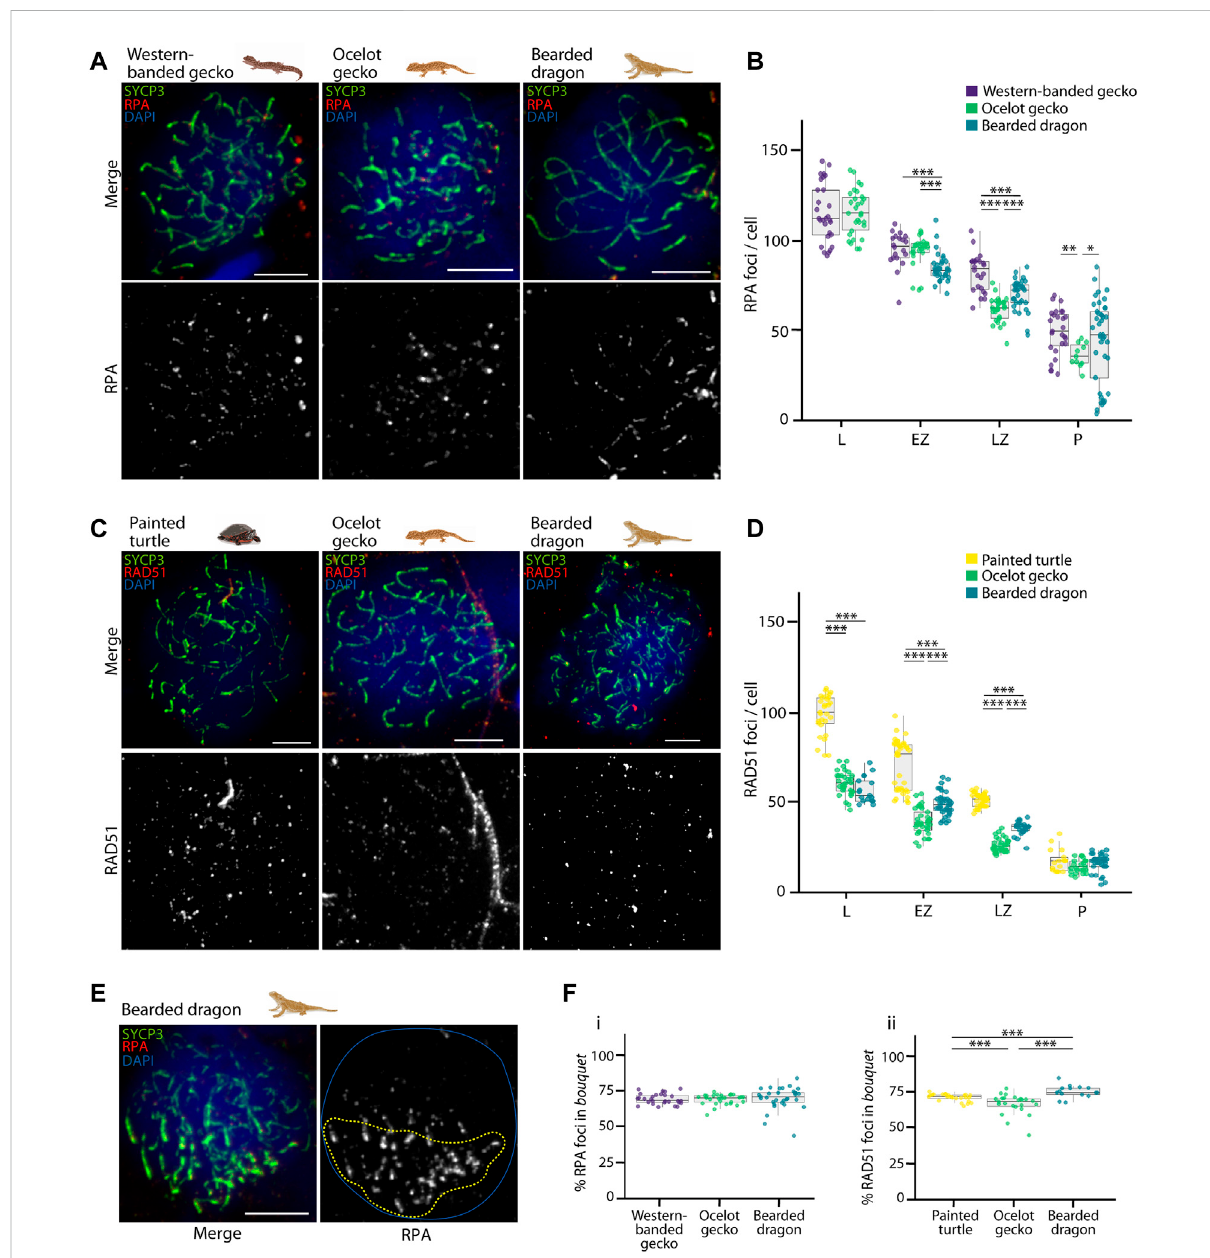
FIGURE 5 Double strand break formation dynamics during reptilian prophase I. (A) Late zygotene spermatocyte spreads labelled with antibodies against SYCP3 (green) and RPA (red), counterstaining the DNA with DAPI (blue) for the western banded gecko, the ocelot gecko and the bearded dragon. Scale bar: 10 μ m. (B) Plot representing the number of RPA foci per cell detected at leptotene, early zygotene, late zygotene and pachytene. (C) Late zygotene spermatocyte spreads labelled with antibodies against SYCP3 (green) and RAD51 (red), counterstaining the DNA with DAPI (blue) for the painted turtle, the ocelot gecko and the bearded dragon. Scale bar: 10 μ m. (D) Plot representing the number of RAD51 foci per cell detected at leptotene, early zygotene, late zygotene and pachytene. (E) Early zygotene spermatocyte spread labelled with SYCP3 (green) and RPA (red), counterstaining the DNA with DAPI (blue) in the bearded dragon. Dashed yellow circle: RPA foci detected in the bouquet . Blue circle: nuclei perimeter. (F) Plots representing the percentage of (i) RPA and (ii) RAD51 foci detected in the bouquet for the western banded gecko, the painted turtle,theocelotgeckoandthebeardeddragon.Onlycellswithawell-de fi ned bouquet wereincludedintheanalysis.Thenumberofcellsexamined per species per stage, illustrated in panels (B,D,F) , are listed in Table 1. Mann-Whitney test (* p < 0.05, ** p < 0.01 and *** p < 0.001). Legend: L, leptotene; EZ, early zygotene; LZ, late zygotene; P,